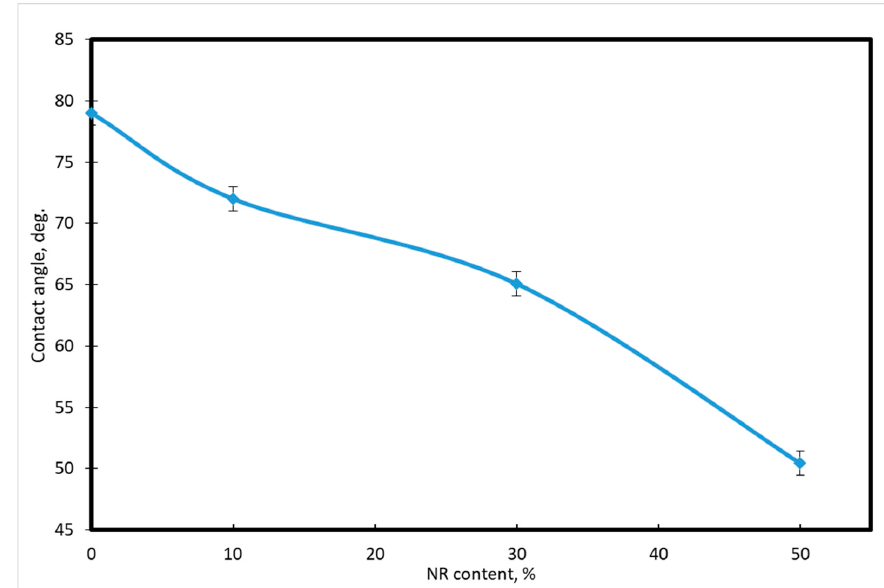
Figure 5. Change of contact angle depending on the content of natural rubber. Table 5. Differential scanning calorimetry of the initial samples.